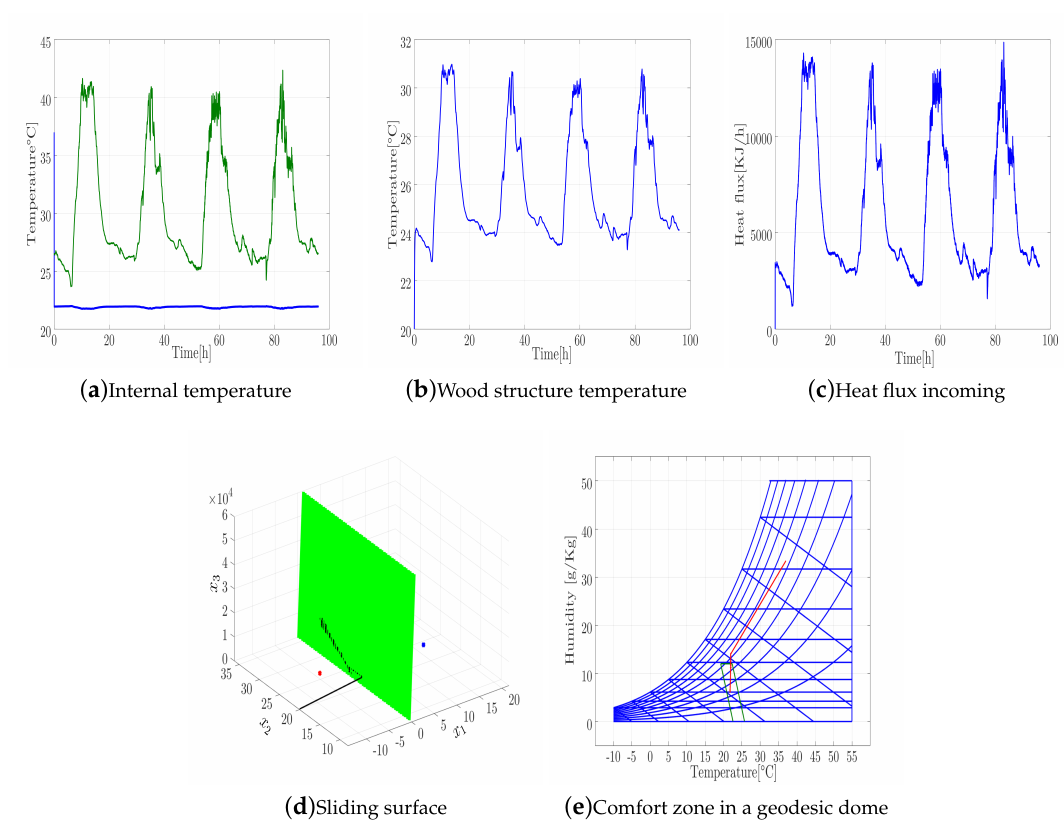
Figure 9. System variables with a 16,000 KJ cooling